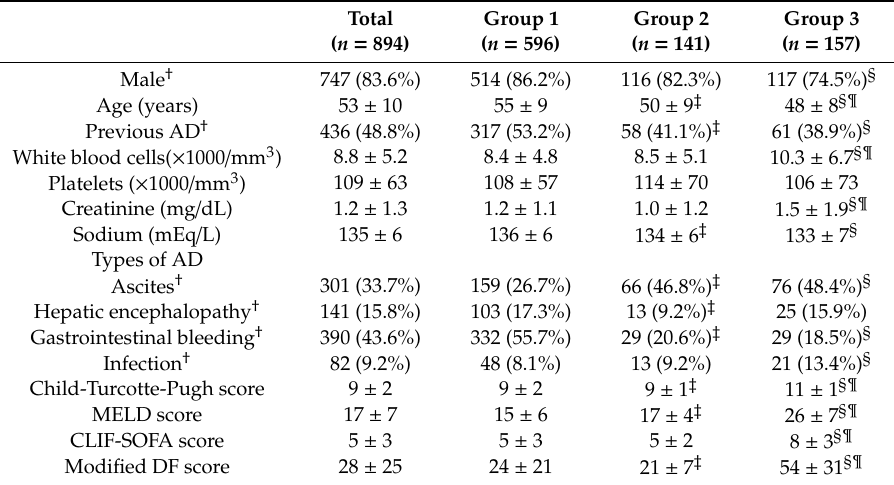
Table 1. Baseline characteristics of the patients at